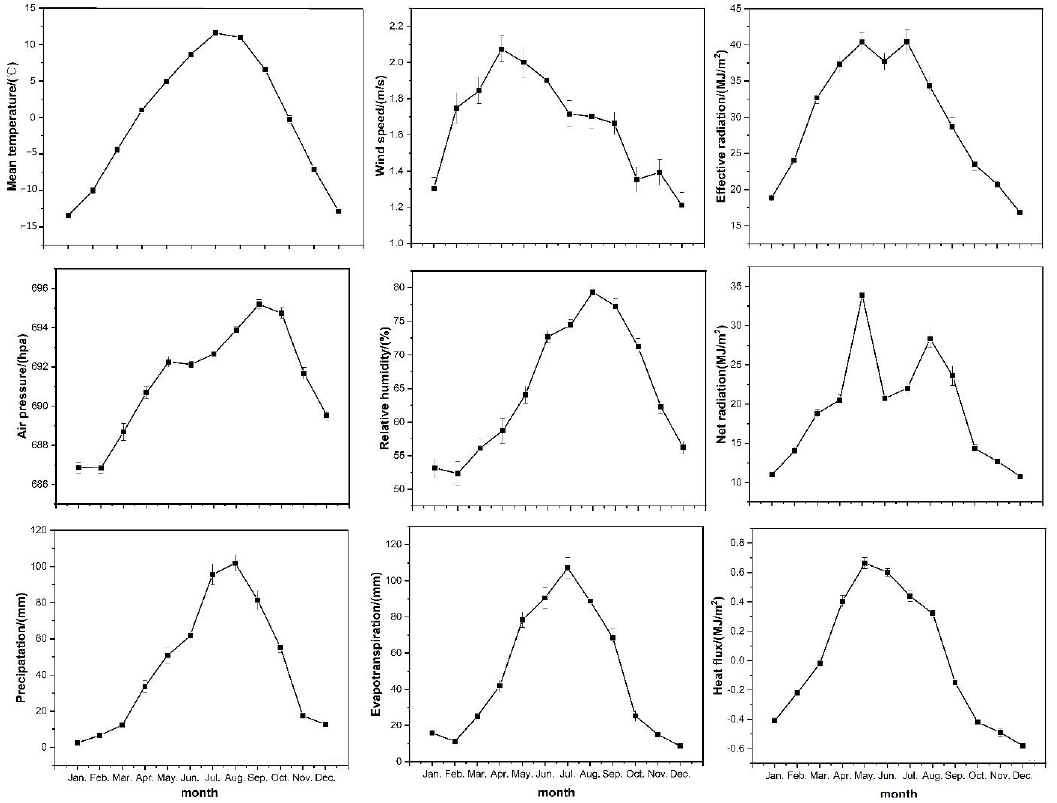
Figure 2. Seasonal variation of meteorological